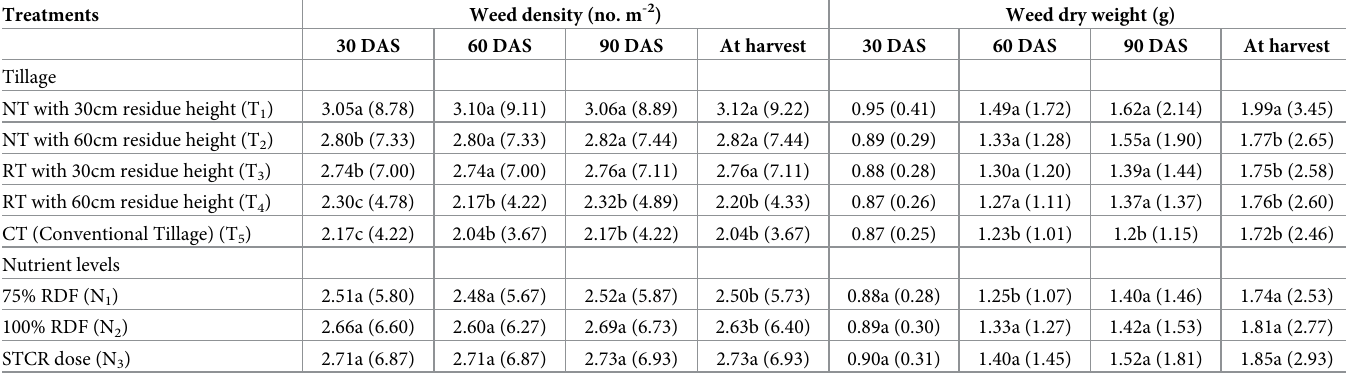
Table 1. Effect of tillage practices, crop residue management and nutrient levels on density and dry weight of weeds in chickpea. Treatments